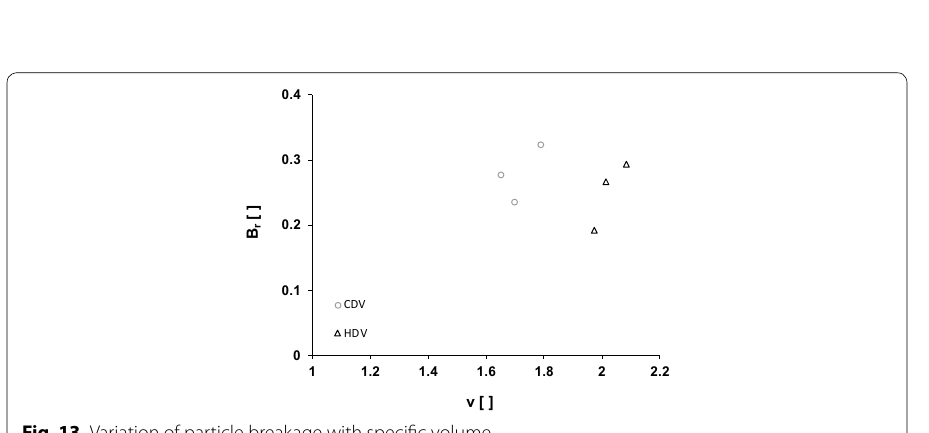
Fig. 13 Variation of particle breakage with specific